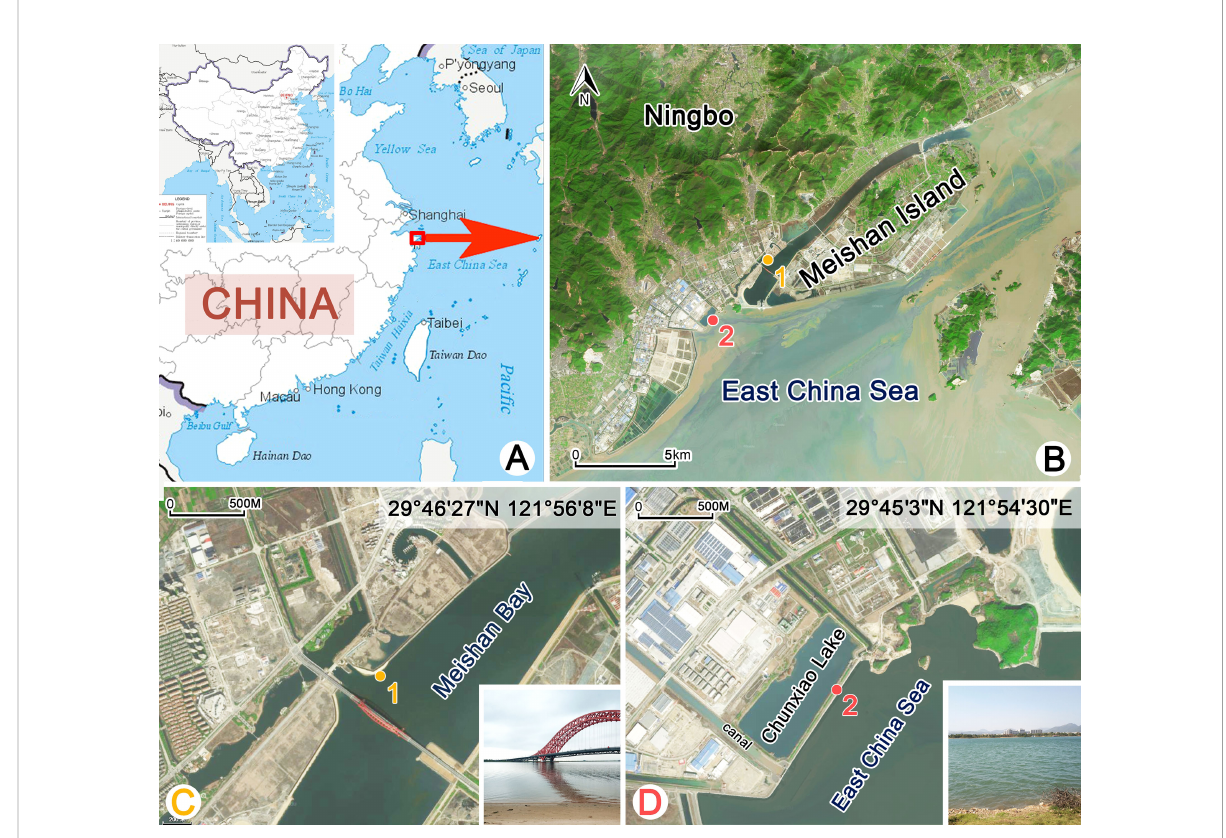
FIGURE 1 Locations and the habitats of sampling sites (A – D) . (A, B) Map of China and the sampling sites. (C) The sandy beach near the Meishan Bay. Sampling site of Aspidisca spina sp. n. (D) Chunxiao Lake. Sampling site of Aspidisca shini sp.